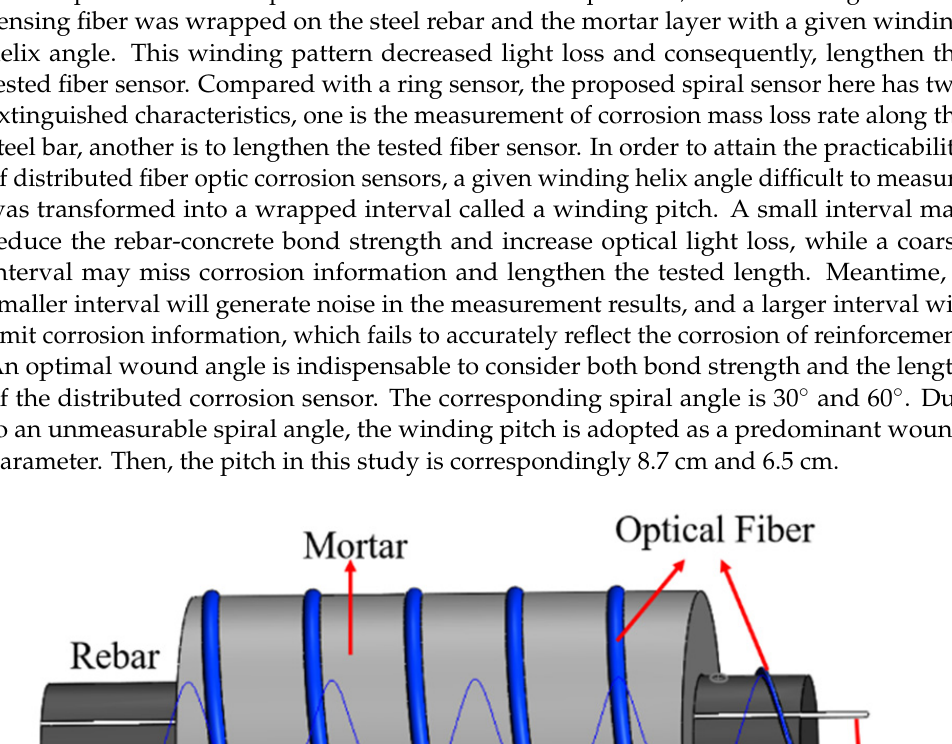
( c ) Figure 2. Corrosion process of the concrete. ( a ) First stage of corrosion; ( b ) Second stage of corro- sion; ( c ) Third stage of corrosion.